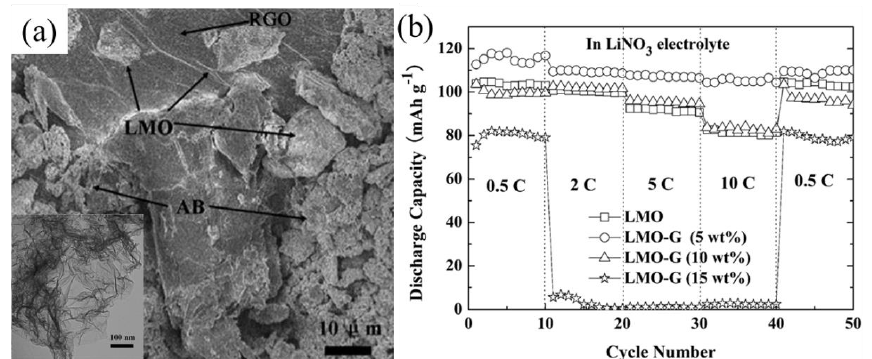
Figure 11. ( a ) SEM image of the LiMn 2 O 4 -RGO (5 wt %), inserted figure shows the TEM image of the RGO; and ( b ) galvanostatic charge/discharge curves of LiMn 2 O 4 -RGO (5 wt %) at various C-rates (modified from Ref. [97] with permission from Royal Society of Chemistry).